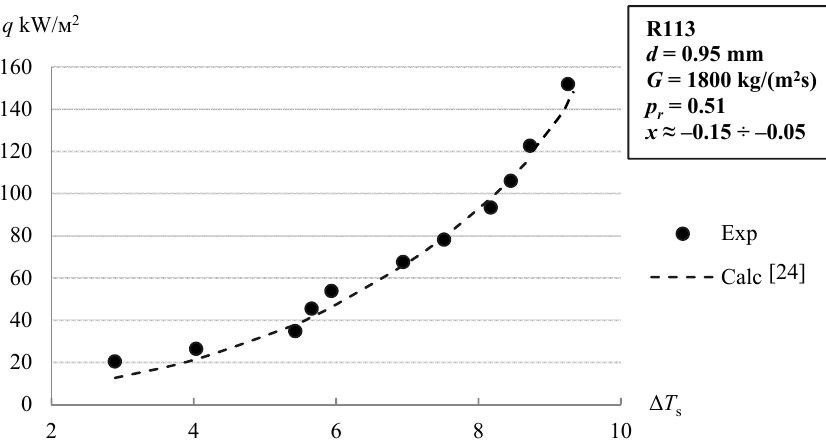
Figure 11. Comparison of the experimental data for subcooled liquid ([7,25], x local ≈ − 0.15 to − 0.05) with the calculated heat transfer data.